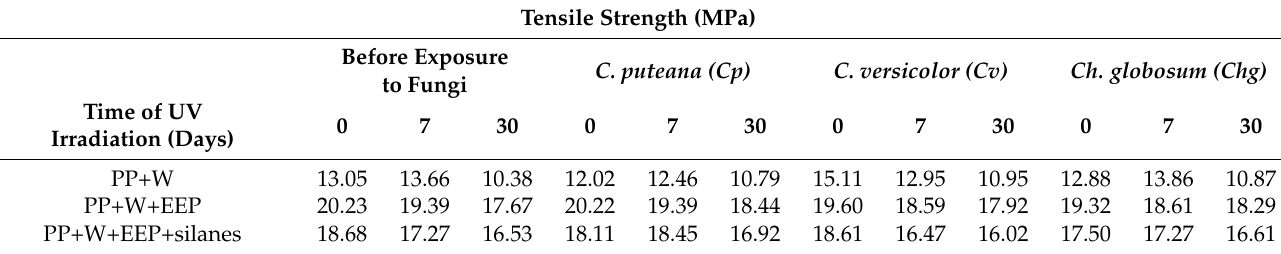
Table 4. Tensile strength of WPCs.